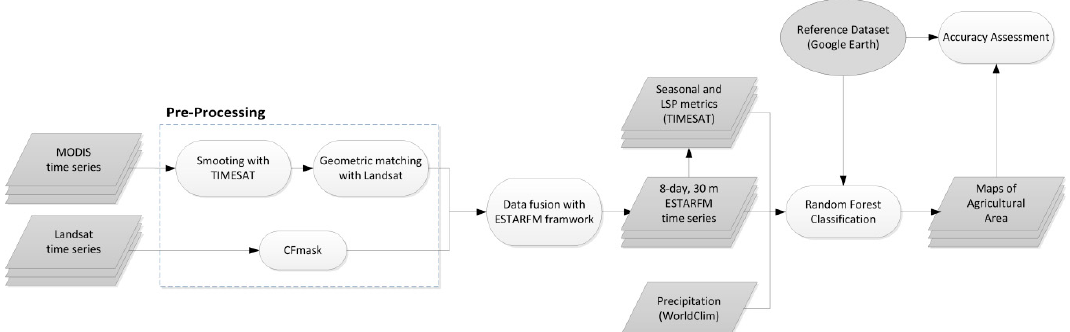
Figure 2. Workflow of pre-processing, data fusion, and classification for the generation of maps of agricultural area for entire Burkina Faso.